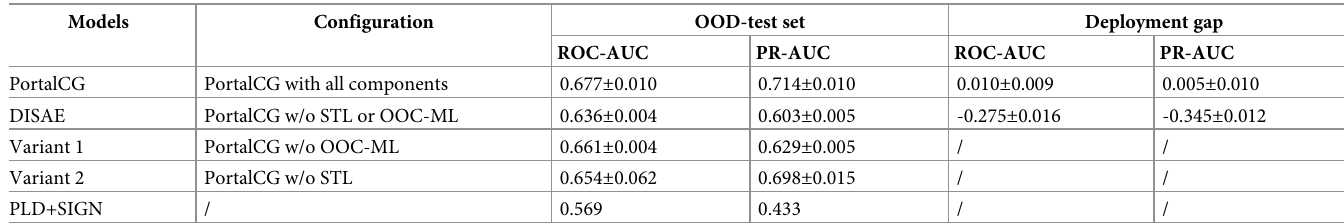
Table 2. Ablation study of the performance of PortalCG.